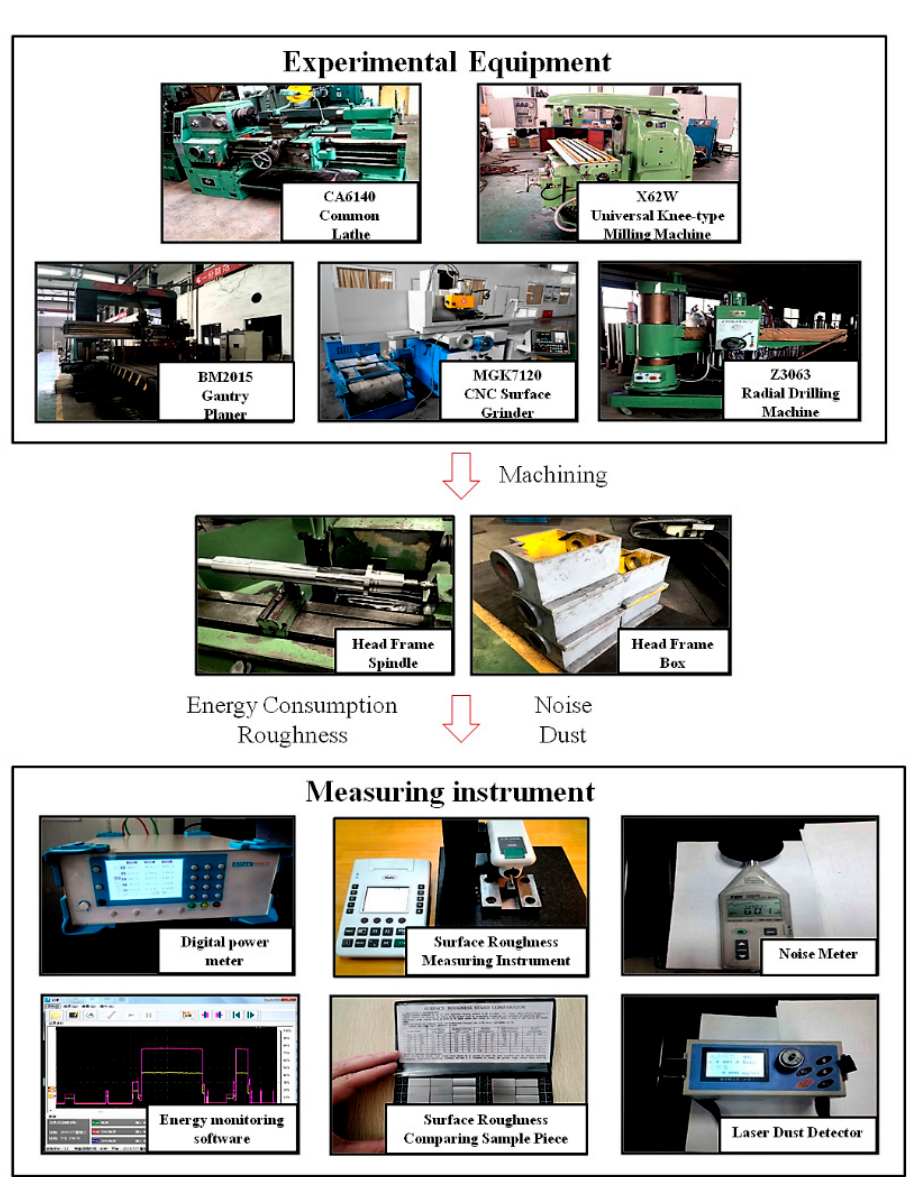
Figure 5. Experimental equipment, experimental workpieces and measuring instruments.